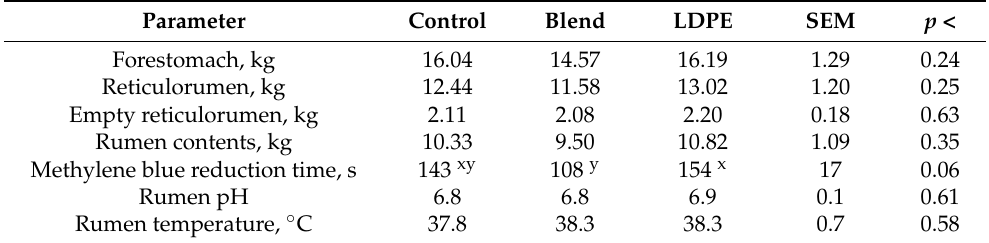
Table 2. Rumen parameters of Holstein bull calves after 30 d of administration of either Control, Blend, or LDPE